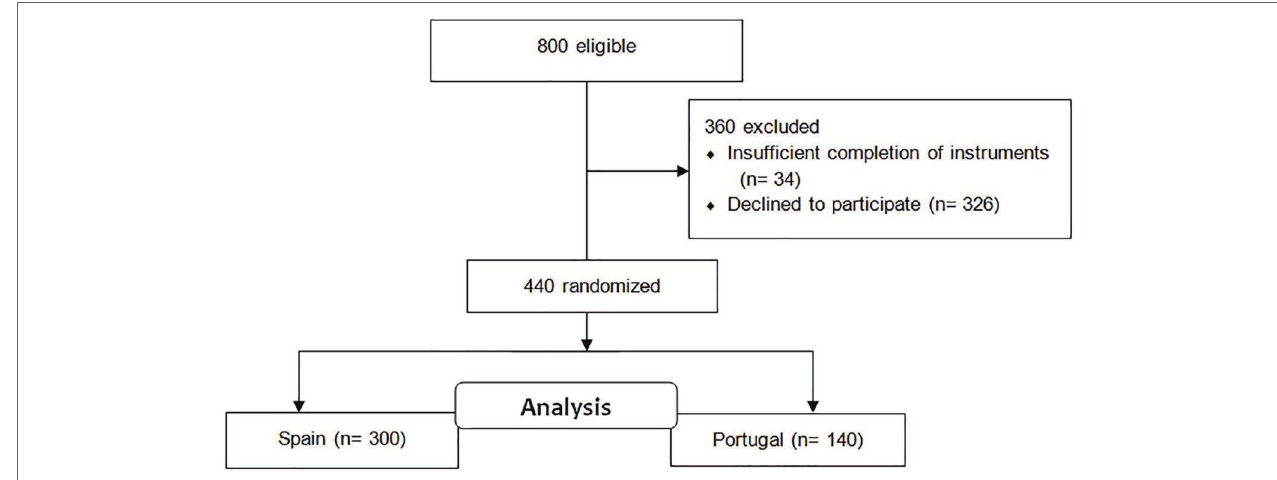
FIGURE 1 | Flow diagram of recruitment of